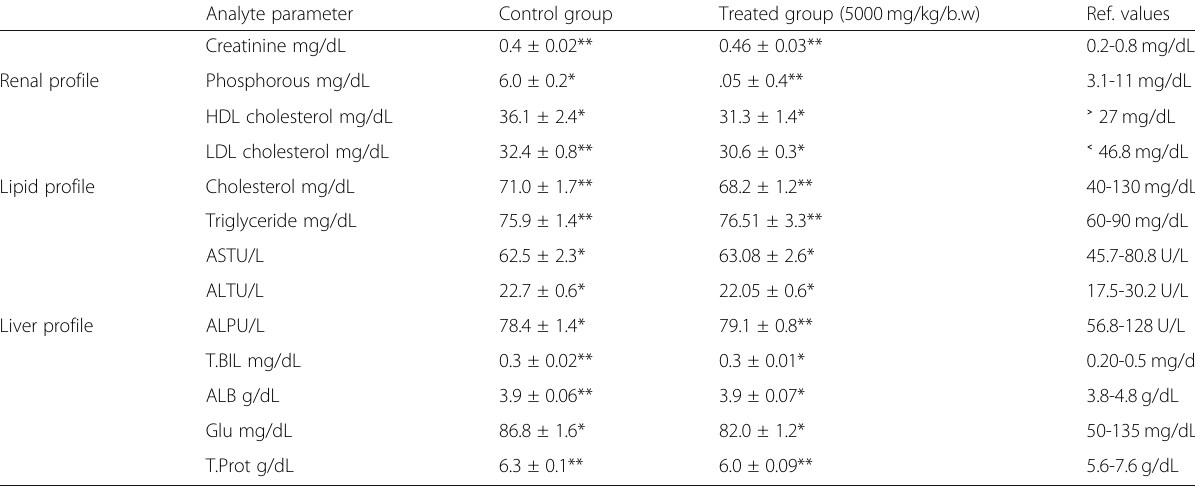
Table 3 Effects of EEPM fruits extract on hepatic, renal, and lipid function indices in male rats Analyte